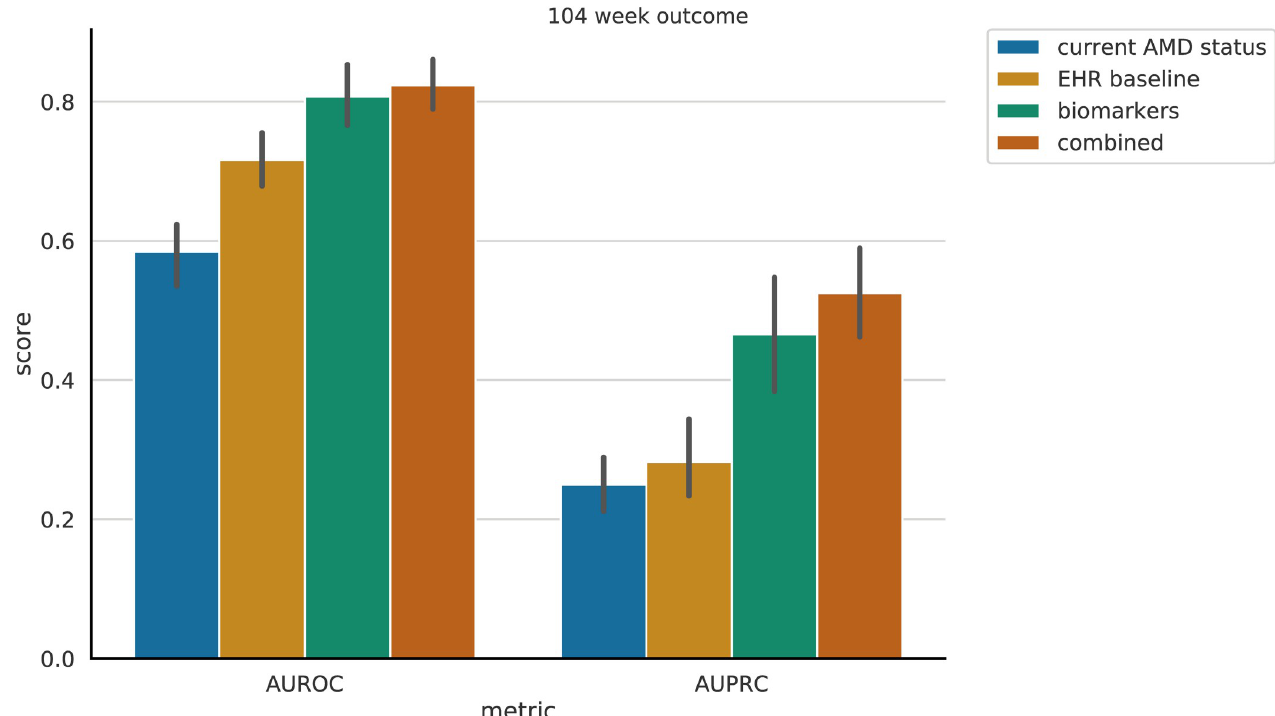
Fig 1. Exudative AMD prediction performance. Left: Areas Under the Receiver Operating Characteristic (ROC) curve. Right: Areas Under the Precision- Recall (PR) curve. Each bar represents the performance utilizing a different set of features (see legend). Error lines represent the 95% confidence intervals, computed using